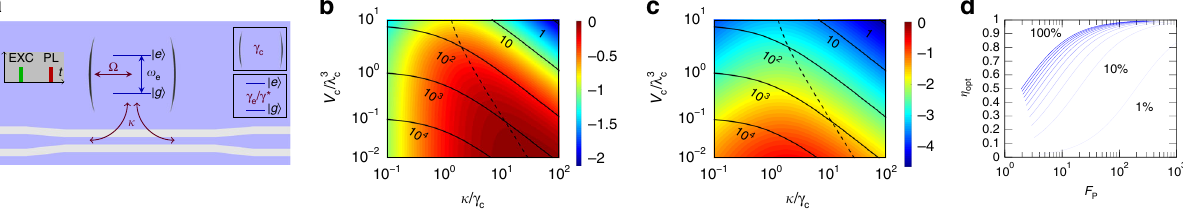
Fig. 4 Integrated cavity-emitter system. a Schematic of an integrated cavity-emitter system, evanescently coupled to a single mode waveguide. The coupling rate between an emitter with frequency ω e and a cavity with resonance frequency ω c is given by Ω . The decay rate from the cavity-emitter system to the guided mode is κ , while the other decay channels of the emitter and cavity are given by γ e and γ c , respectively. The emitter dephasing is described by γ *. The system is excited (EXC) by a short pulse and subsequently the single photon PL is collected. b , c Single photon extraction ef fi ciency η ( b ) and extraction-indistinguishability product η V ( c ) as a function of cavity mode volume V c and cavity decay rate κ . The black solid lines represent lines of constant Purcell factor F P , while the black dashed line represents ( V c , κ ) combinations for which η is maximal. The parameter values used to generate plots b , c are Q i = 10000, Γ = 3 MHz, γ e = 300 MHz, cos 2 θ d = 1/2 (i.e. average over different orientations of the quantum emitter), γ * = 100 GHz 44 , n d = 4 and λ = λ λ = 750nm and an effective refractive index of n = 1.6 for the fundamental TE-mode (which is calculated c 0 / n eff with a free-space wavelength of 0 eff using a commercial FDTD solver from Lumerical). Both plots are on a log 10 color scale, i.e. 0 corresponds to perfect η = 1 or η V = 1. d Optimum η opt (evaluated at ( V c , κ ) combinations for which η is maximal) as a function of F P for different values of Γ ranging from 0.01 γ e to γ e (different quantum yields)